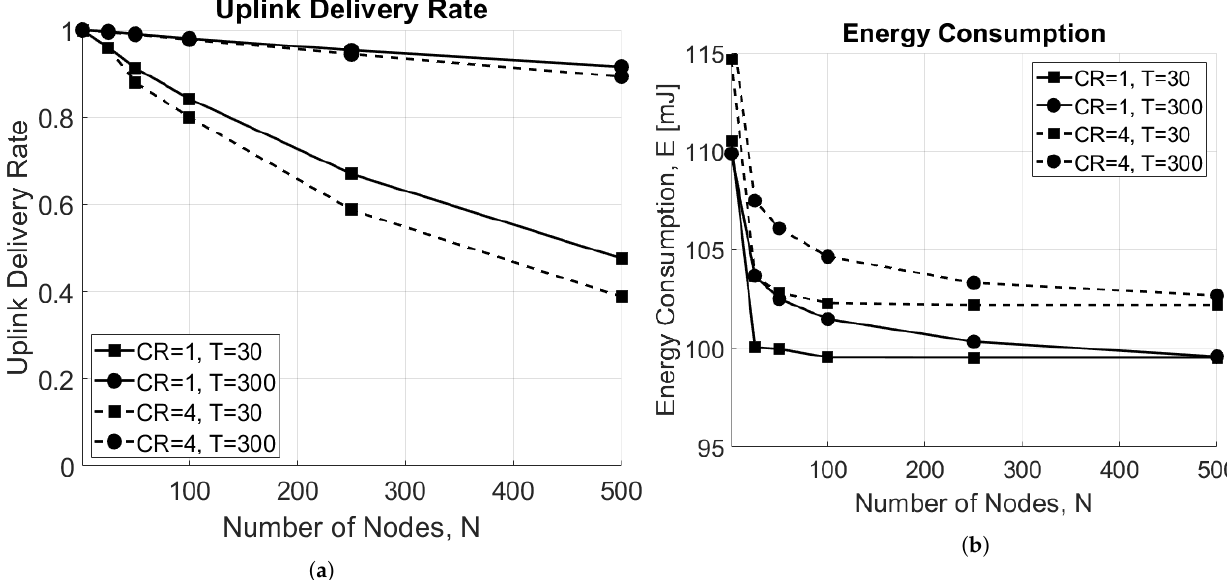
Figure 8. Impact of the number of end devices, N. ( a ) Uplink delivery rate as a function of number of EDs, N. ( b ) Energy consumption as a function of number of EDs,